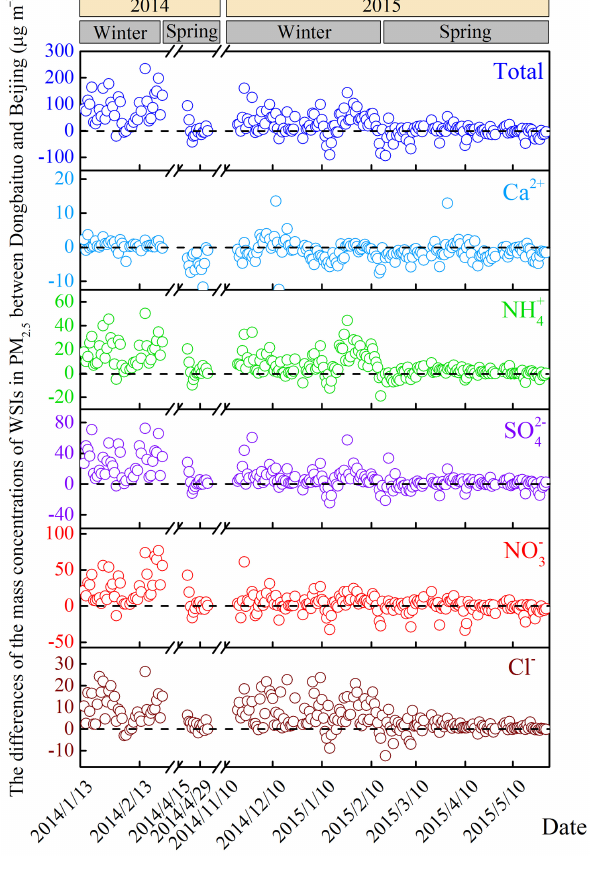
Figure 5. The D values of the mass concentrations of WSIs in PM 2 . 5 between DBT and BJ during the sampling period in winter and spring of 2014–2015.